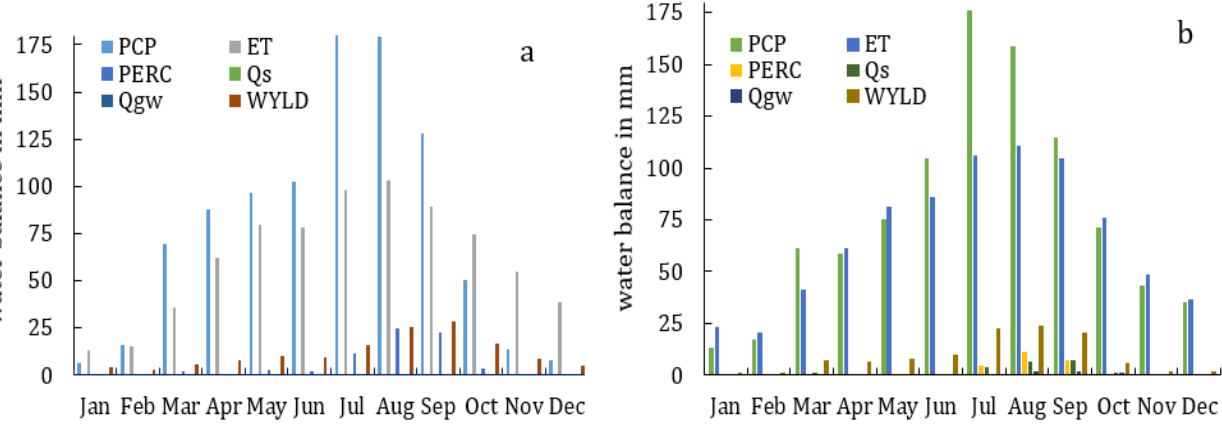
Figure 7. Spatial variation of water balance components in Katar and Meki subbasins (1999 – 2014).